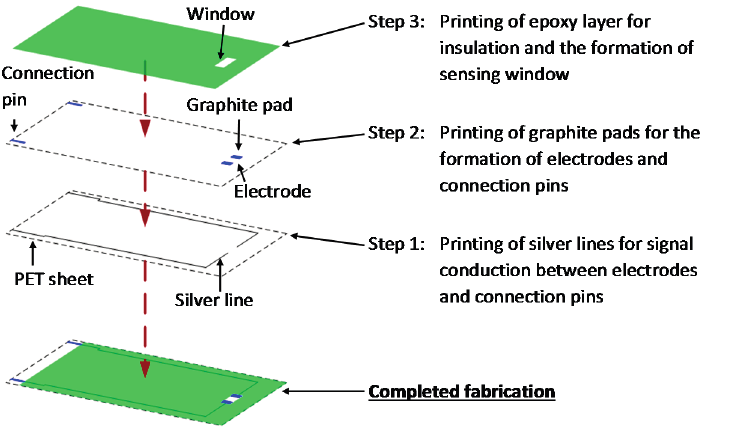
Figure 1. Fabrication procedure of the designed DCP immunosensor, using polyethylene terephthalate (PET) as substrate. Each layer of printing was allowed to dry at 100 °C for 30